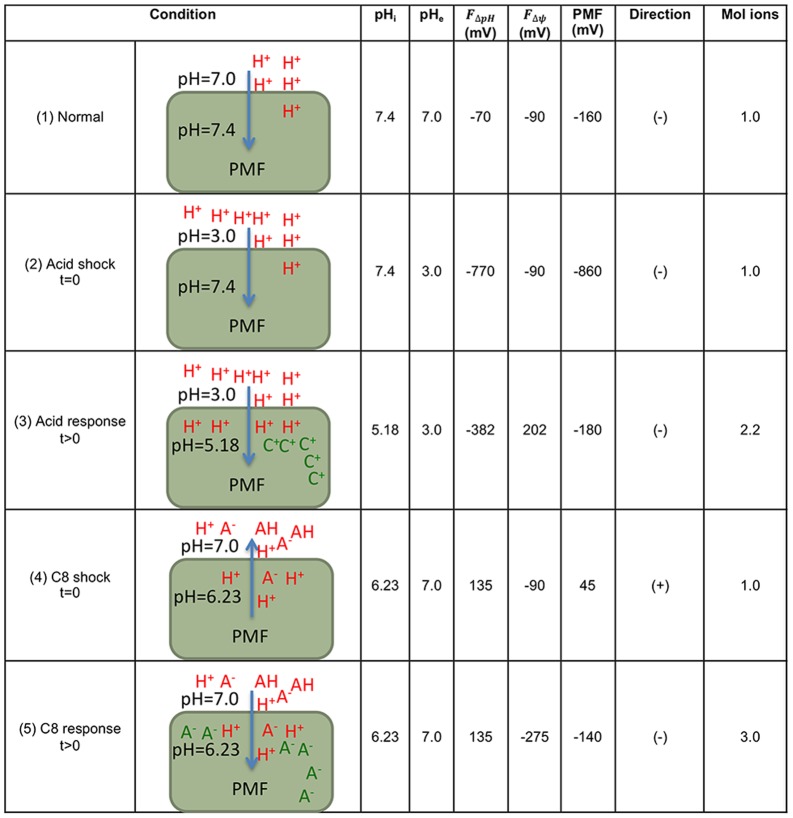
Simulations of the effect of the electrochemical gradients on the proton motive force.The appropriate range for E. coli cells is −140 to −180 mV. pH values are measurements from Figure 2 at 20 mM. Assumption 1: An average of −160 mV is used for the normal PMF. The target PMF is within the range of −140 to −180 mV. Assumption 2: Shock conditions are the instantaneous outcome of the PMF after an extreme change in the environment. Assumption 3: The cell can initiate a response that gives times to adjust the PMF to the target range. Assumption 4: Rapid addition of a strong mineral acid (e.g., HCl) adds an equal amount of anions and protons, which does not change the membrane potential. Assumption 5: C8 is at a sufficiently high concentration that it rapidly integrates into the cell membrane and releases its proton inside the cell, which is not reversible. A negative (−) PMF indicates protons diffusing into the cell, whereas a positive (+) PMF indicates protons diffusing out of the cell. A negative (−)Δψ indicates an overall negative ion gradient due to anions, whereas a positive (+)Δψ indicates an overall positive ion gradient due to cations. The mol ions is the molar ratio from the normal condition. pHi- intracellular pH; pHe- extracellular pH; - ΔpH associated electrochemical force; - membrane potential associated electrochemical force; PMF- proton motive force; A− (red) C8 anion; A− (green) another anion; C+ any cation.